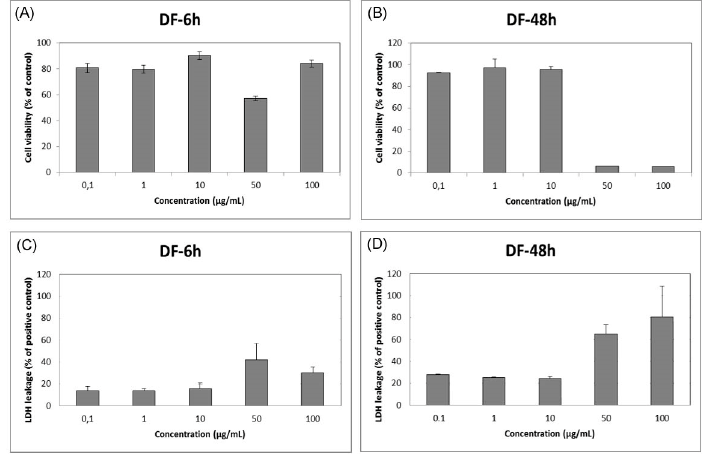
Figure 2. In vitro cytotoxicity assays by ( A , B ) MTT assay; ( C , D ) LDH assay.